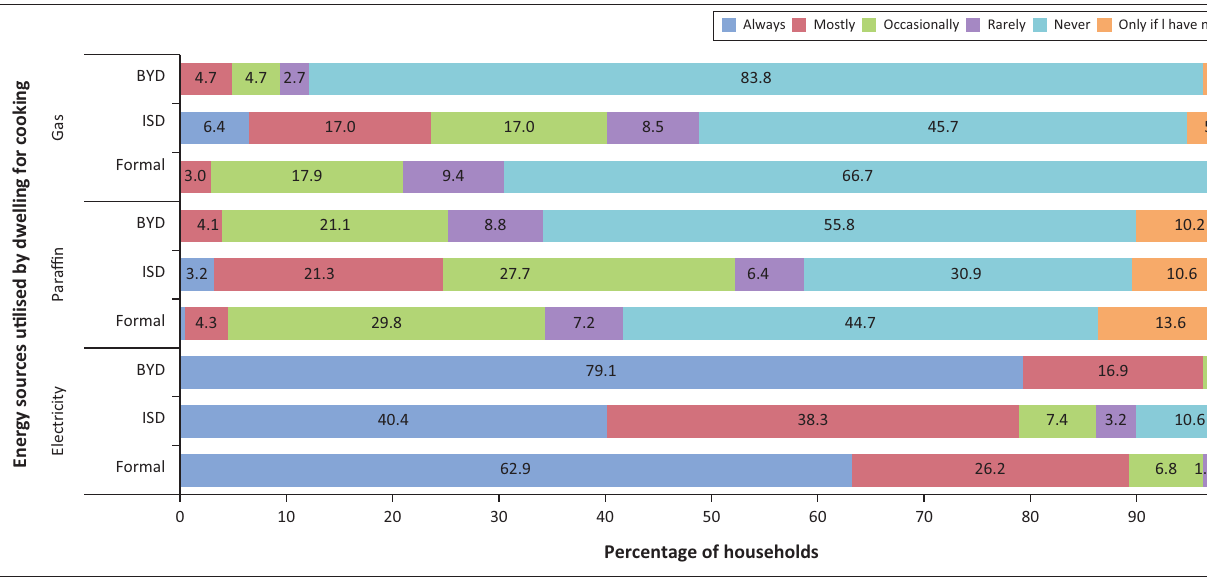
FIGURE 7: Energy sources used for cooking by